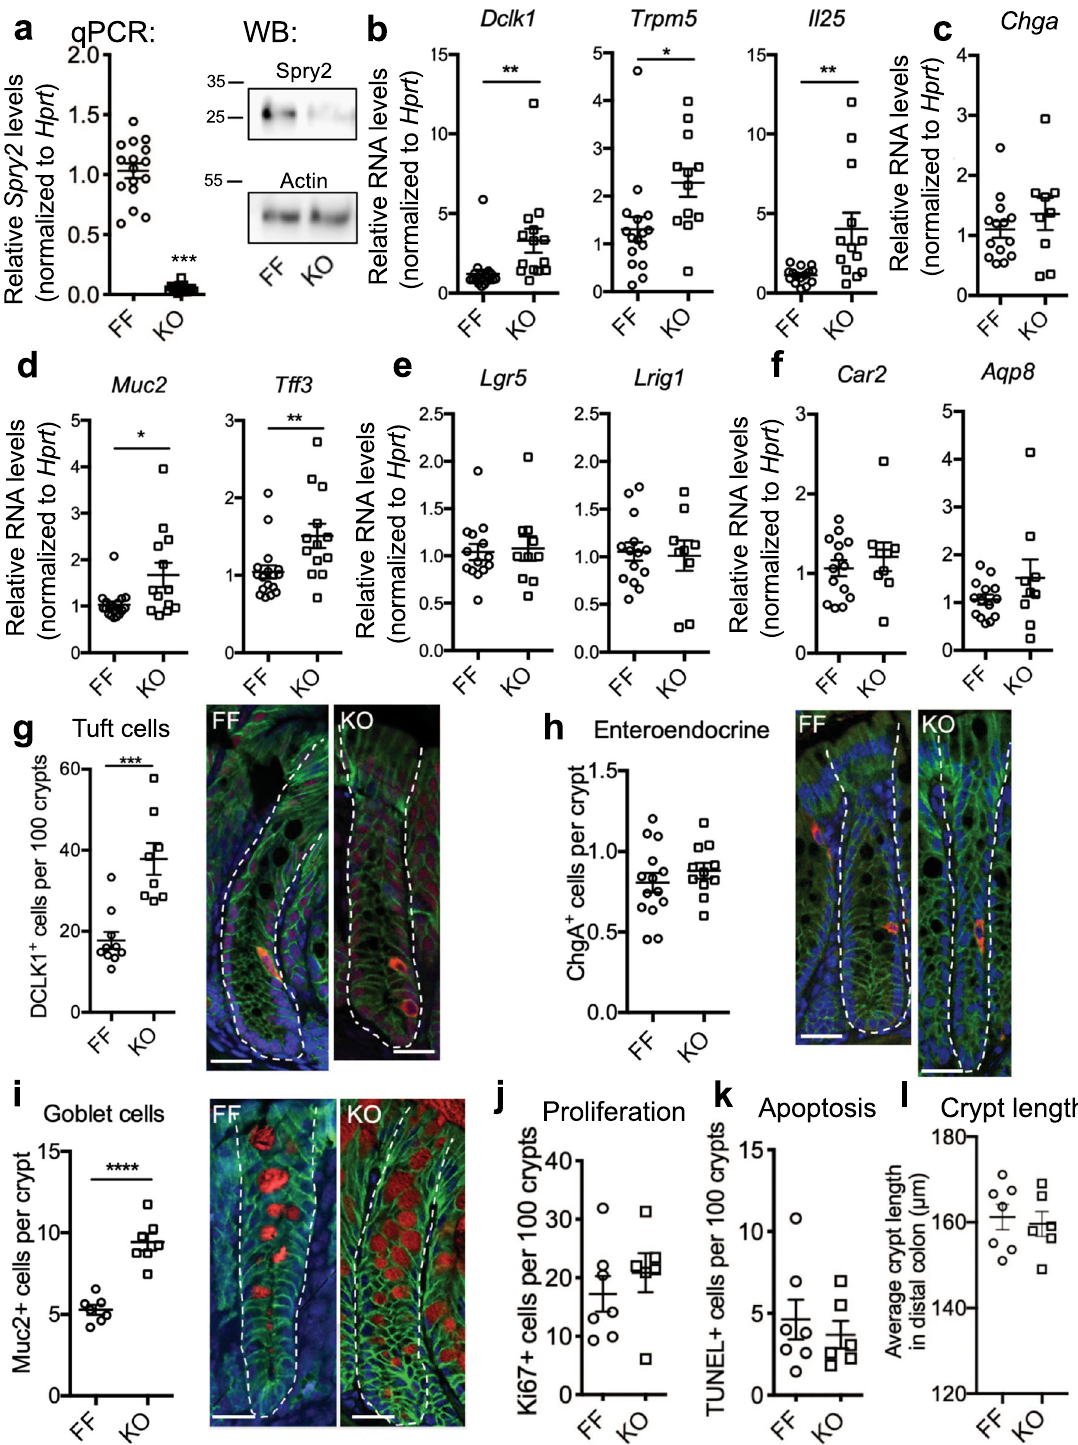
Fig. 2 Loss of epithelial Sprouty2 results in expansion of colonic tuft and goblet cell numbers. a Deletion of Sprouty2 in Spry2 IEKO mice was con fi rmed by qPCR and western blot of colonic homogenates. b Tuft ( Dclk1 , Trpm5 , and Il25 ), c enteroendocrine ( Chga ), d goblet ( Muc2 and Tff3 ), e stem ( Lgr5 and Lrig1 ), and f absorptive enterocyte ( Car2 and Aqp8 ) markers were measured in Spry2 IEKO colonic homogenates by qPCR. g Tuft (Dclk1 + ; in red), h enteroendocrine (ChgA + ; in red), and i goblet (Muc2 + ; in red) cells were quanti fi ed by immuno fl uorescence staining of distal colonic sections. Green = E-cadherin. Scale bar = 25 µ m. j Proliferation (Ki67 + ), k apoptosis (TUNEL + ), and l crypt length were quanti fi ed in distal colons. Data are presented as mean ± SEM. Analyzed by two-sided t test. * p < 0.05; ** p < 0.01; *** p < 0.001; **** p < 0.0001. Exact p values where appropriate are as follows b Dclk1 p = 0.0065; Trpm5 p = 0.0203; Il25 p = 0.0046; d Muc2 p = 0.0124; Tff3 p = 0.0099; g p = 0.0002. Number of mice analyzed, from fi ve independent litters, in each panel as follows: a 16 per group; b Dclk1 19 FF, 14 KO; Trpm5 16 FF, 12 KO; Il25 15 FF, 13 KO; c 14 FF, 9 KO; d Muc2 17 FF, 13 KO; Tff3 17 FF, 13 KO; e , f 14 FF, 9 KO; g 10 FF, 8 KO; h 14 FF, 8 KO; i 7 FF, 7 KO; and j – l 7 FF, 6